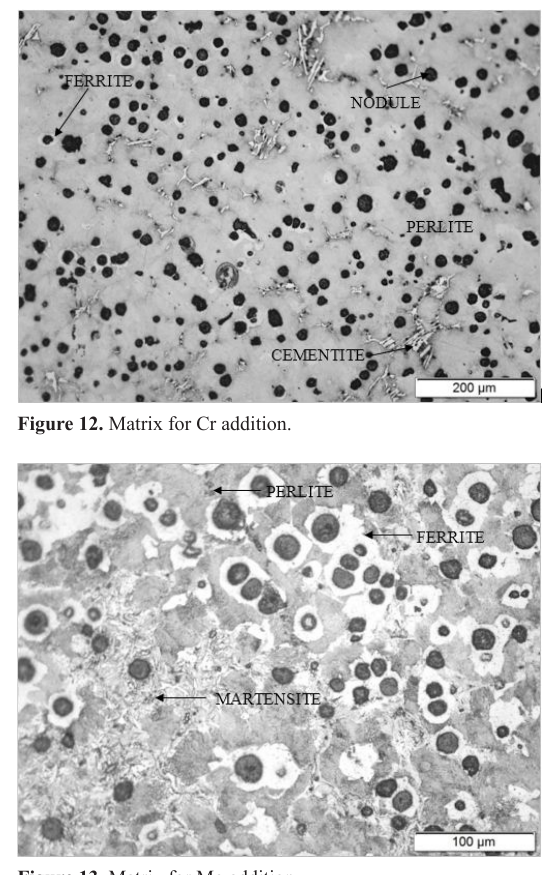
Figure 13. Matrix for Mo addition.